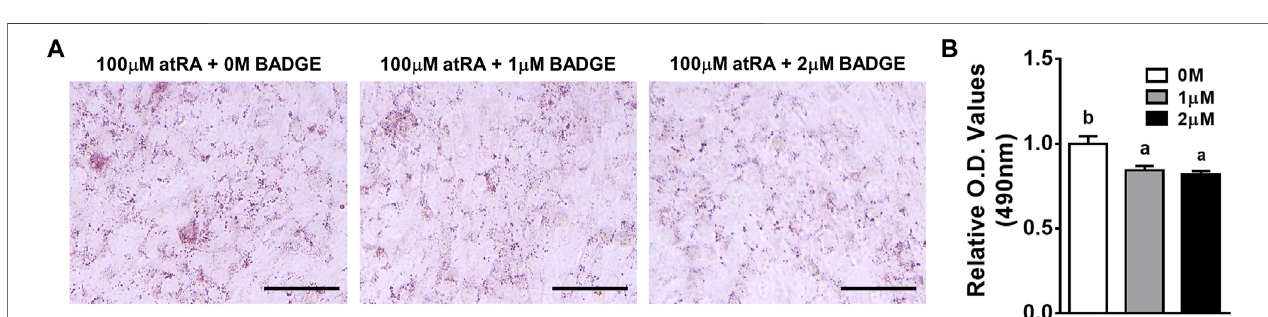
Frontiers in Cell and Developmental Biology |